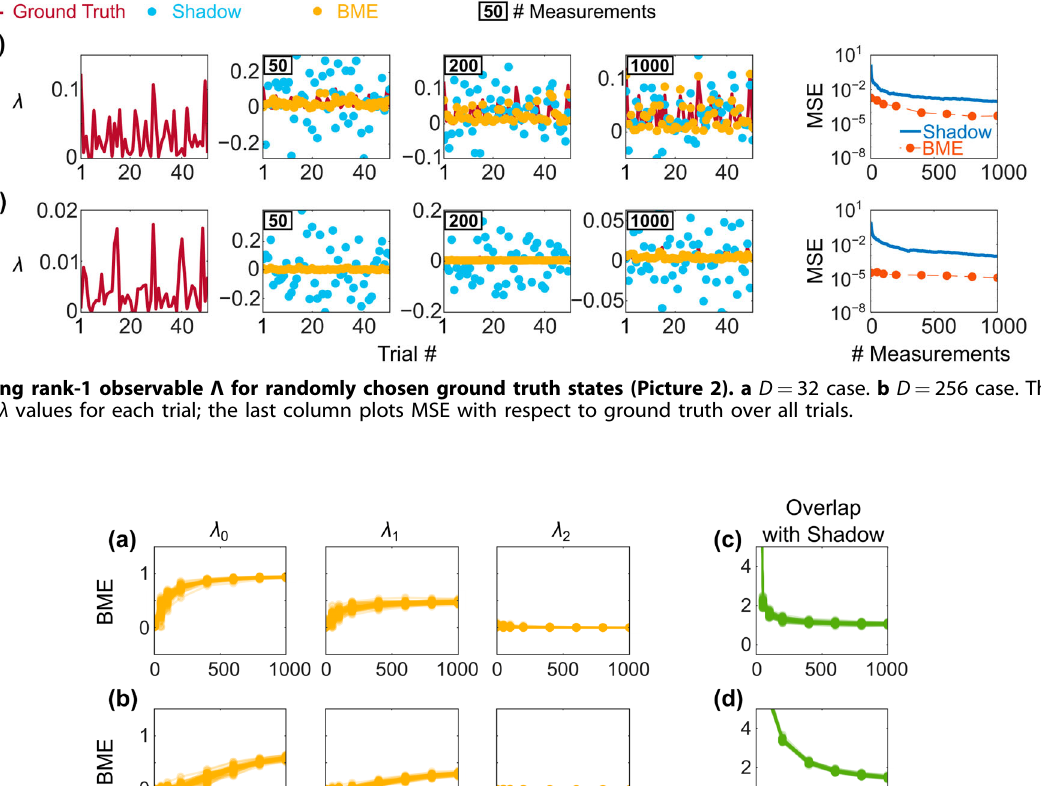
Fig. 3 Bayesian inference results utilizing the pseudo-likelihood in Eq. (9). a D = 32 case. b D = 256 case. The overlap with shadow, Tr ρ plotted in c for D = 32 and d for D = 256.